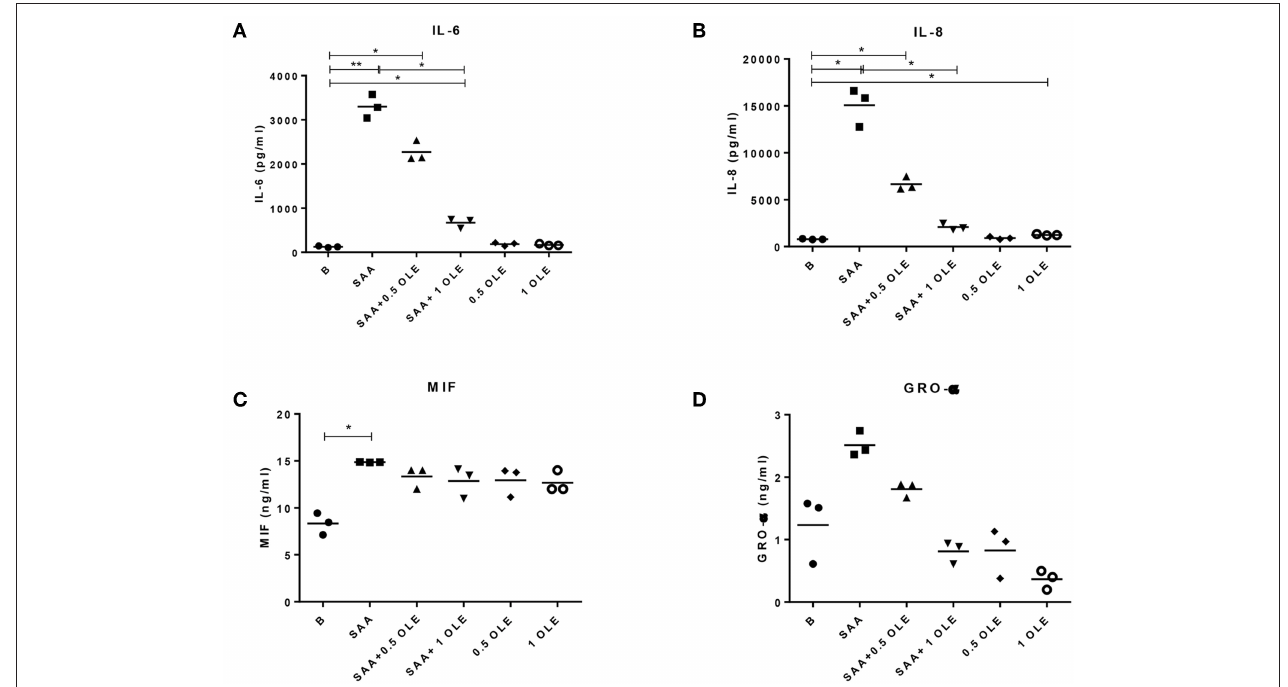
FIGURE 1 | OLE decreases SAA-driven release of pro-inflammatory cytokine IL-6 and chemokine IL-8 from HCAEC. The amount of IL-6 (A) , IL-8 (B) , MIF (C) , and GRO- α (D) in cell culture supernatants were measured by ELISA. The mean of 3 biological replicates is shown. HCAEC were treated with OLE (0.5 mg/ml, 1 mg/ml) 45min prior to SAA addition (1,000nM, 24h). Data was analyzed using RM one-way ANOVA test with Tukey’s multiple comparison test * p > 0.05 ** p >